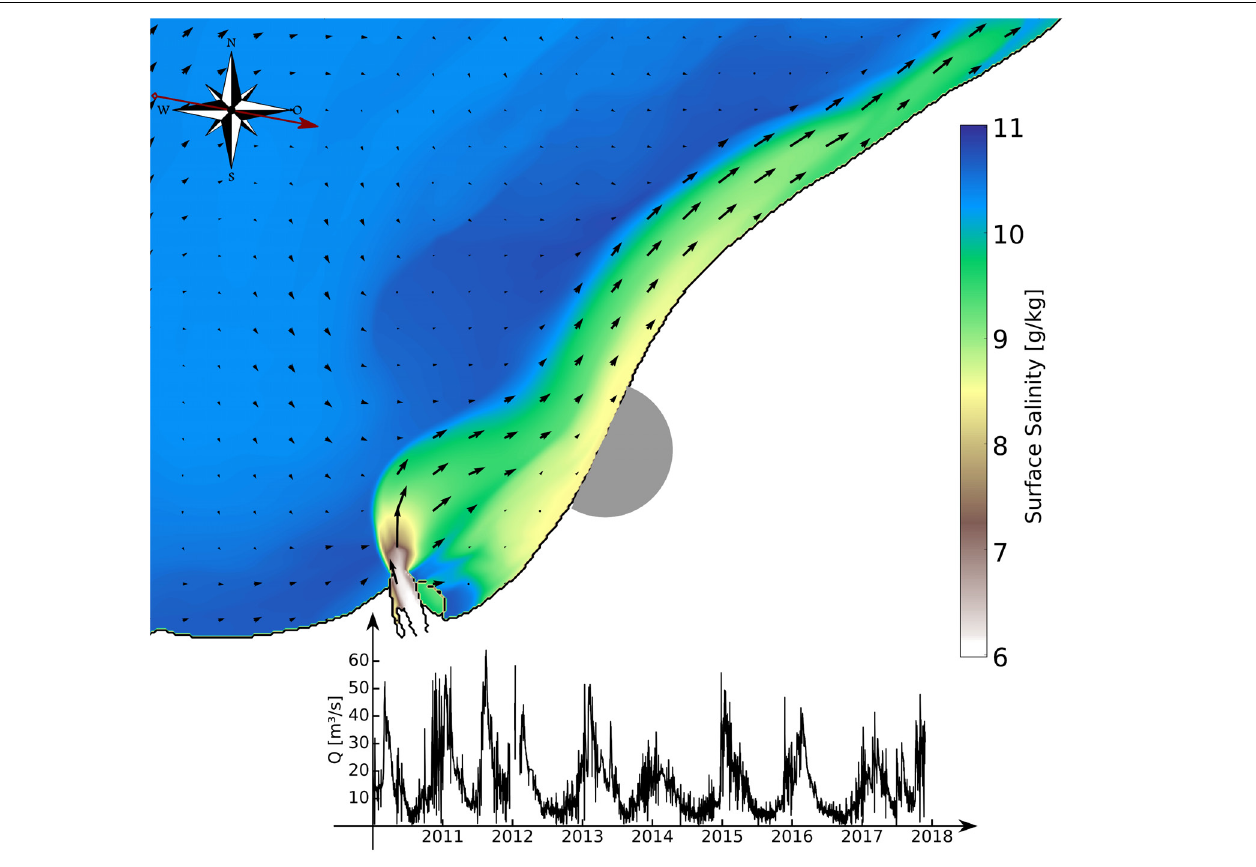
FIGURE 5 | Snapshot of simulated surface salinity outside the mouth of the Warnow estuary under westerly wind forcing. Inset: Time series of observed freshwater runoff from the river Warnow during the years 2011–2017, data provided by the Office for Agriculture and Environment Mittleres Mecklenburg.